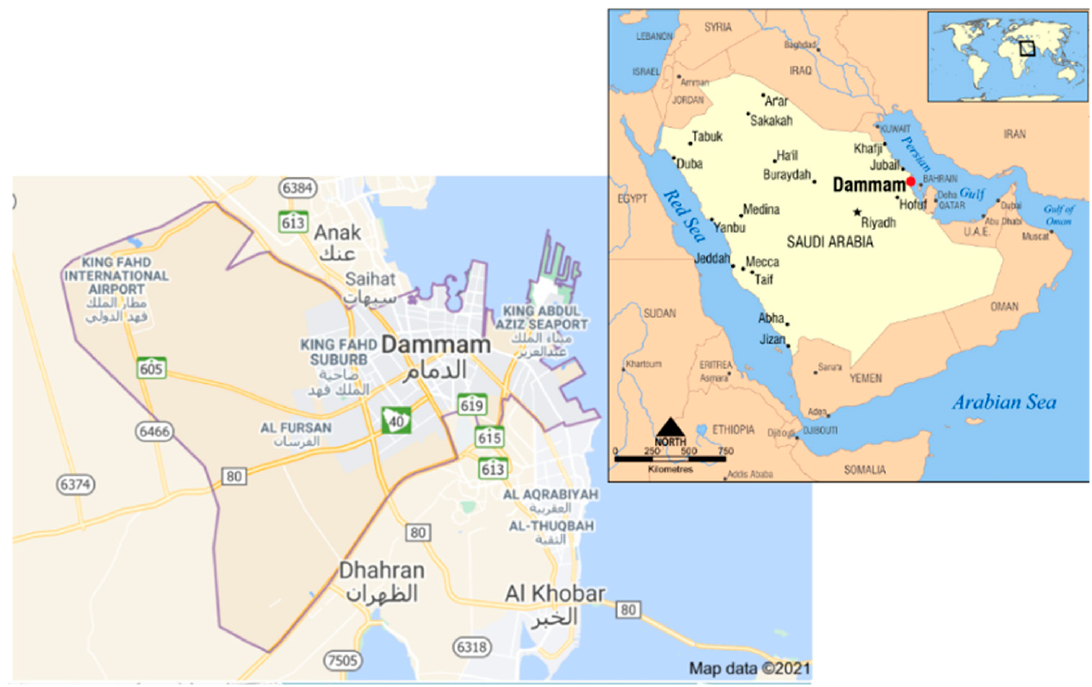
Figure 1. Location of Dammam metropolitan area, Saudi